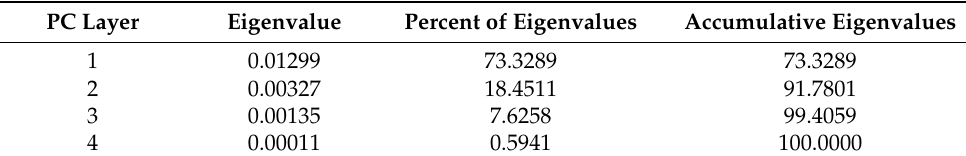
Table 4. Principal component analysis statistics.